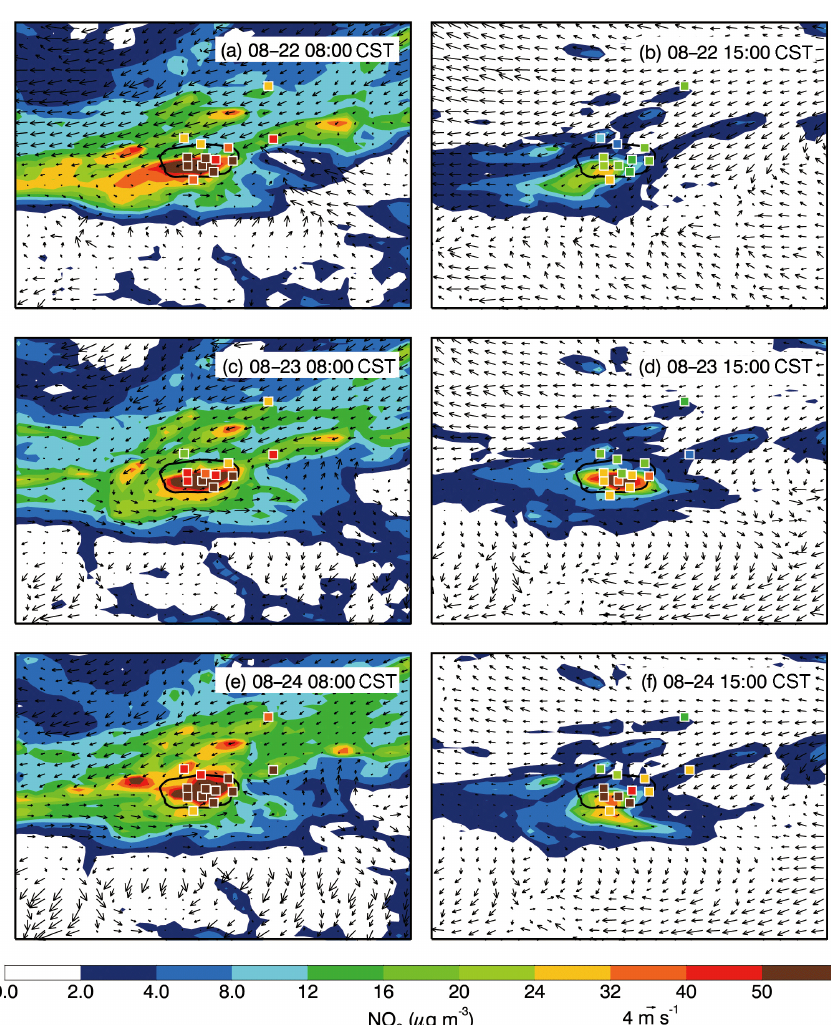
Figure 9. Pattern comparison of simulated vs. observed near-surface NO 2 concentrations at 08:00 and 15:00CST from 22 to 24 August 2013. Colored squares: NO 2 observations; color contour: NO 2 simulations; black arrows: simulated surface winds.